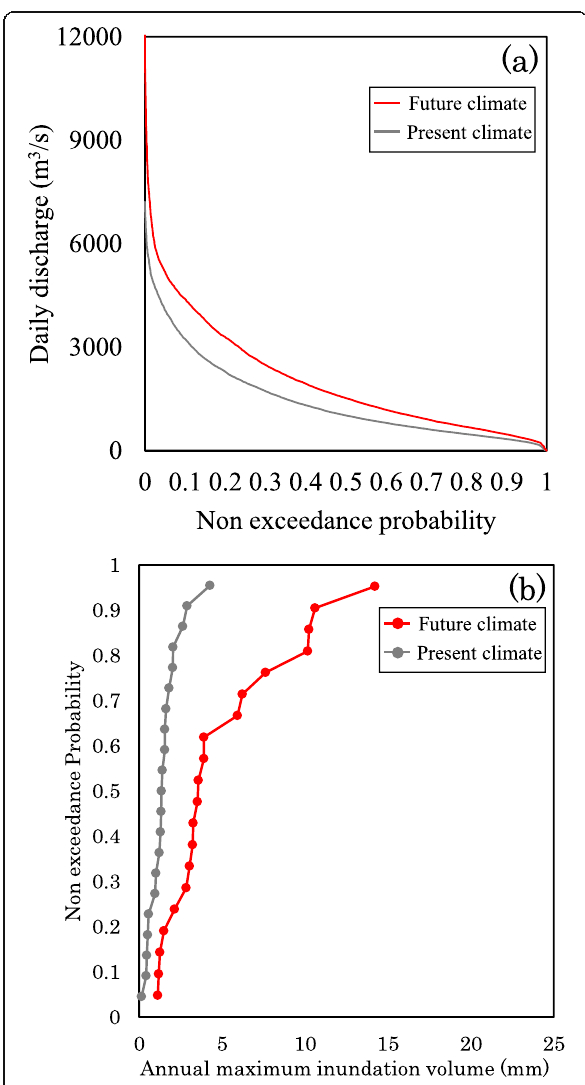
Fig. 11 Hydrological variables of bias-corrected present and future data. a Flow duration curve and b CDFs of annual maximum inundation